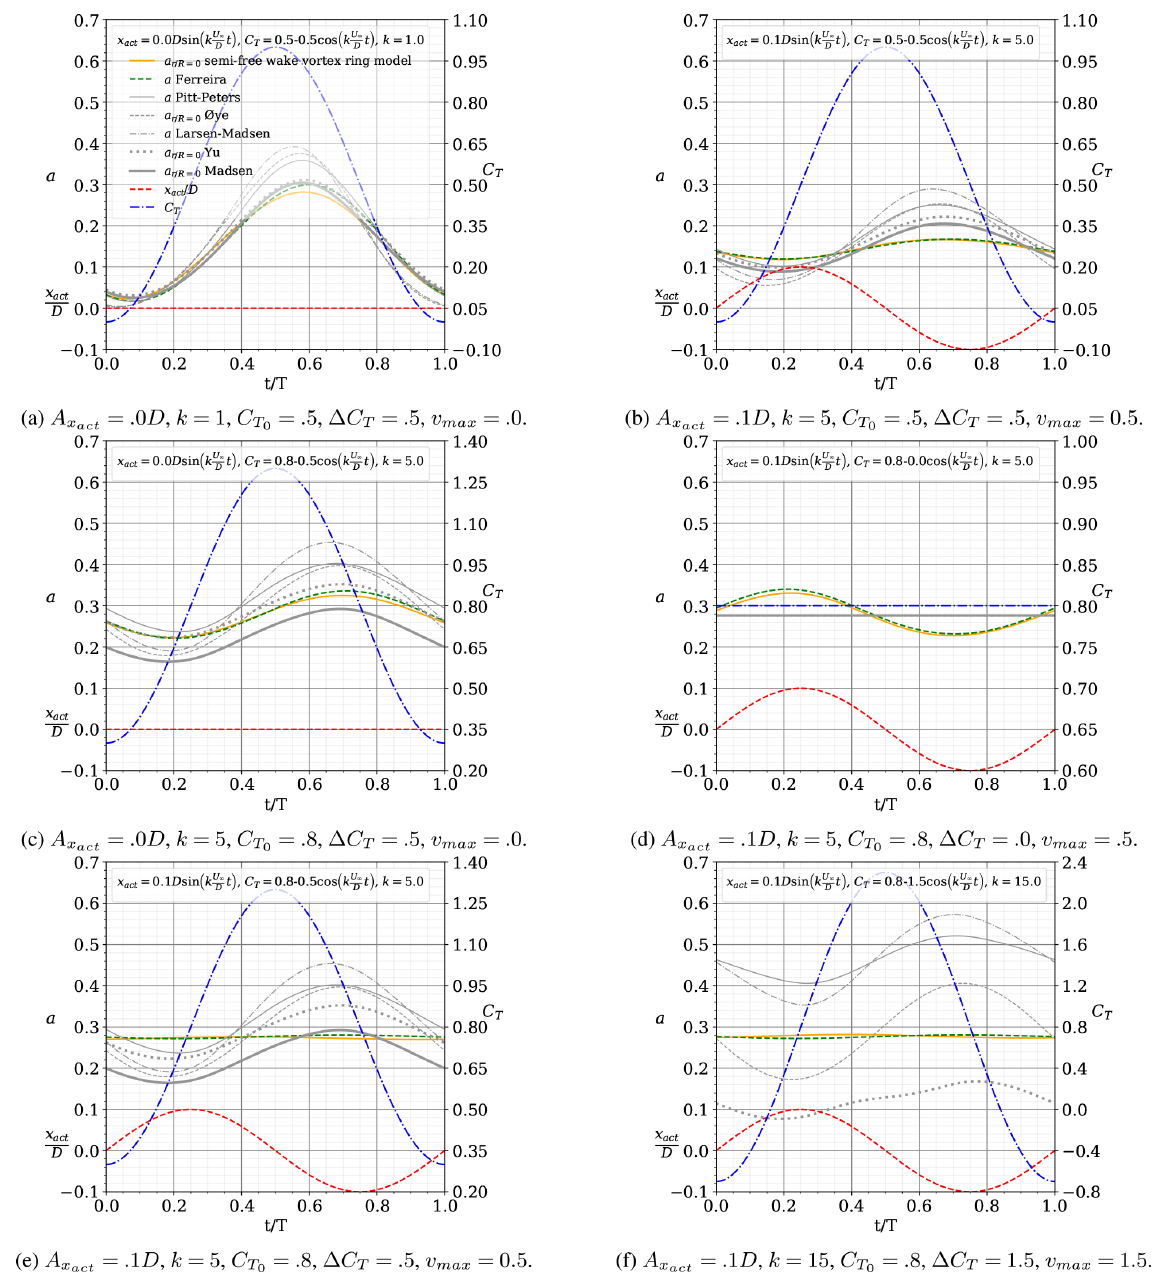
Figure 7. Comparison of the results of induction by the semi-free-wake vortex ring model, the proposed dynamic inflow model Ferreira, and the Pitt–Peters, Øye, Larsen–Madsen, Yu and Madsen models for a sinusoidal surge motion with x act = A x − (cid:49)C T cos( kU ∞ /Dt ) (also plotted). The results are plotted over one period, along the non-dimensional time t/T and with C T = C T 0